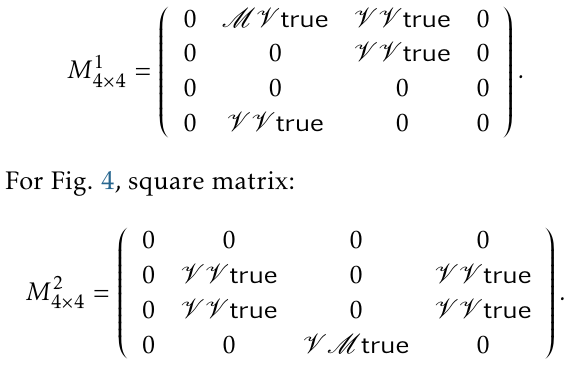
Fig. 3 and Fig. 4. In which: For Fig. 3, square matrix: